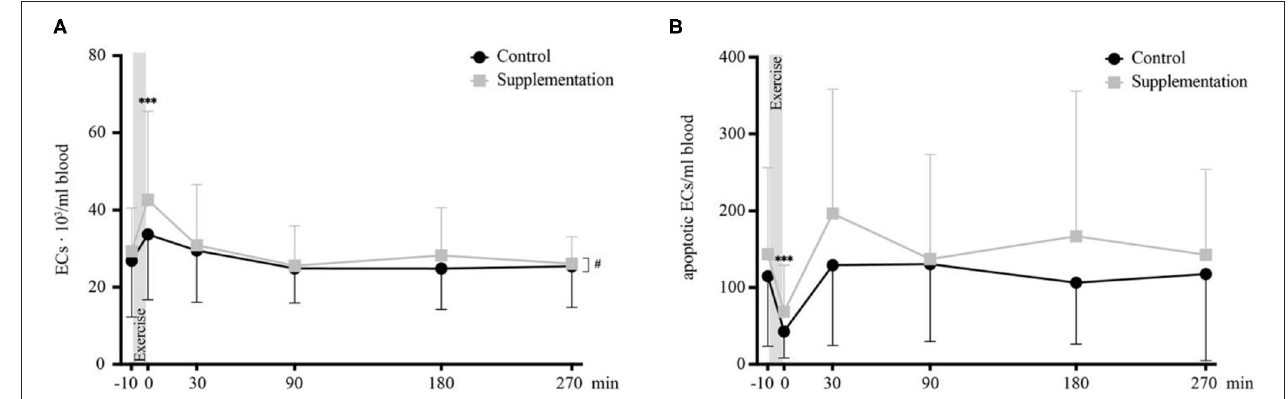
FIGURE 7 | Total number of ECs (A) and number of apoptotic ECs (B) in cells/ml blood ( n = 18). Values are mean ± SD. Differences from baseline are indicated by *, with *** p < 0.001. Differences between the two interventions are indicated by # , with # p < 0.05.